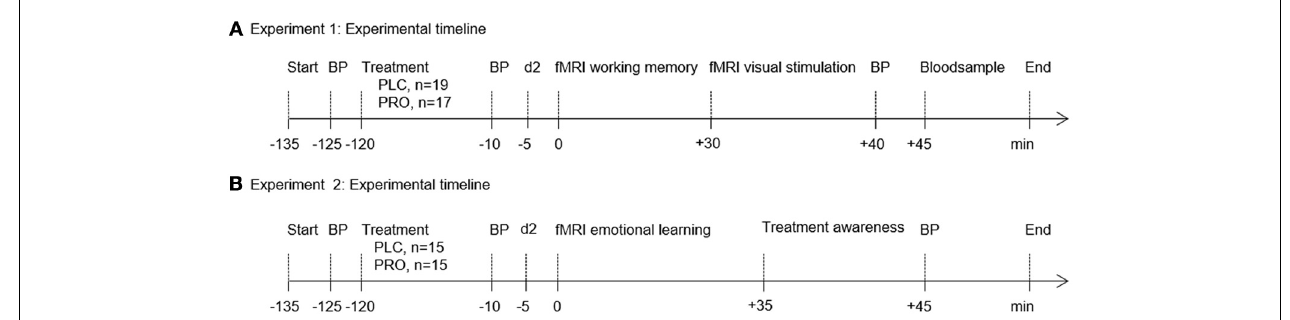
FIGURE 1 | Experimental timelines and fMRI paradigms. Experimental timeline of Experiment 1 (A) and Experiment 2 (B) . In both experiments volunteers were administered either placebo (PLC) or propranolol (PRO) 120min before testing. Blood pressure (BP) was measured at the time of verum/placebo administration as well as immediately before and after the scanning session. To control for confounding effects of propranolol on